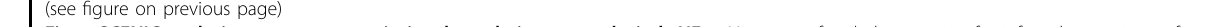
Fig. 4 SCENIC analysis uncovers transcriptional regulation networks in hsHF. a Heatmap of scaled expression for inferred transcription-factor gene regulatory networks (SCENIC) in 9 cell types of hsHF. b , c Gene regulatory network analysis using SCENIC identi fi es critical transcriptional regulation for (b) noMx cells or (c) Mx cells. The predicted TFs and their target genes are shown. The TFs are highlighted in yellow. d Violin plots of canonical BMP target gene pathway scores in different cell types. e Representative ( n = 5 HFs from 3 individuals) IF images of hsHF sections and magni fi ed views. Scale bars: 200 μ m. f Representative ( n = 3) IF images and magni fi ed views of squared areas on mouse telogen (P50) or anagen (2 weeks post depilation at P50) HF sections (Scale bars: 50 μ